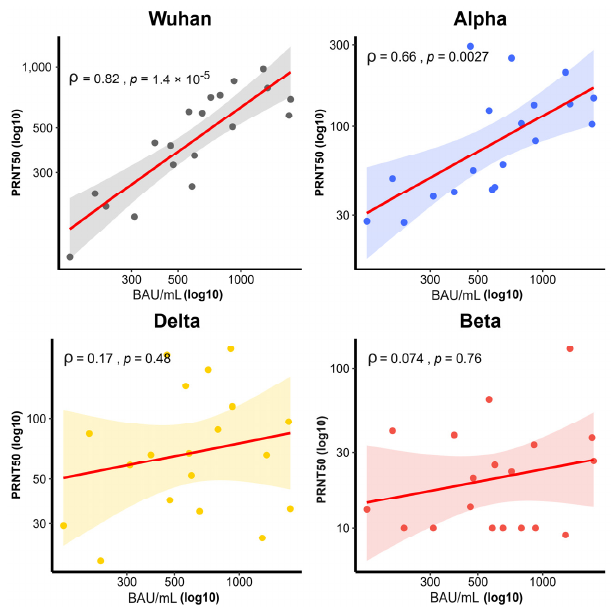
Figure 5. Correlation between PRNT 50 titer with Ab to anti-SRBD level by virus variant group. Correlation (solid line), 95% confidence intervals (curved line). Wild-type ( ρ = 0.82, p < 0.001), Alpha variant ( ρ = 0.66, p = 0.0027), Beta variant ( ρ = 0.074, p = 0.76), and Delta variant ( ρ = 0.17, p = 0.48). Spearman’s rank correlation coefficient was used for assessment. Serum was collected 2 weeks after participants in the IV-AV group received a vaccination.